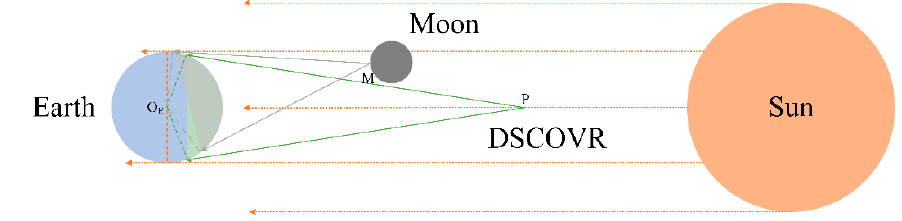
Figure A1. The lit area viewed from a Moon-based platform and Deep Space Climate Observatory (DSCOVR).